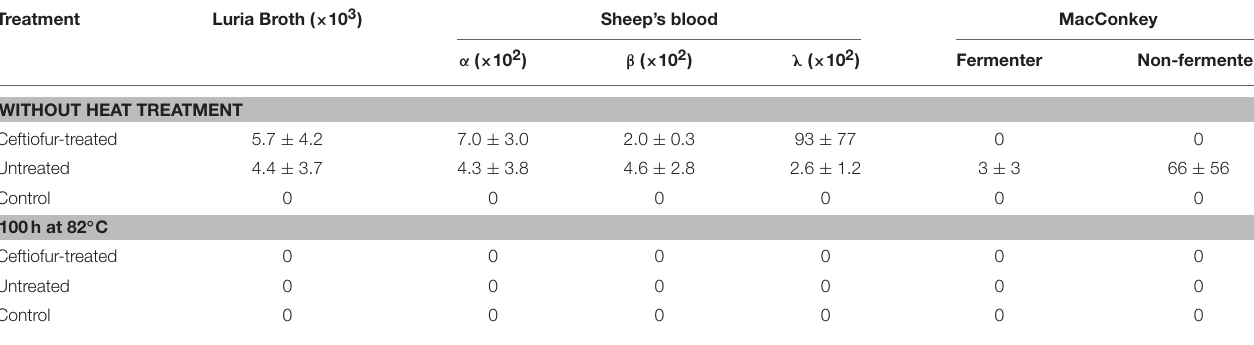
TABLE 3 | Mean colony forming units ( ± standard error, n = 3 ) per ml of fresh ( < 2h old) 1% (vol vol − 1 ) waste milk from Ceftiofur-treated and untreated cows in base medium, and base medium without a carbon source. Treatment